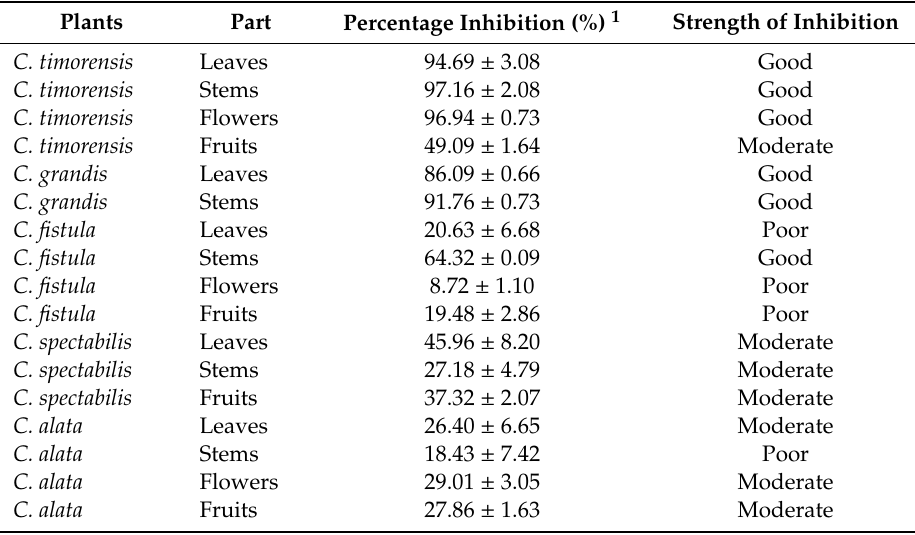
Table 1. Percentage inhibition of methanol extracts of Cassia spp. at 0.2 mg / mL.